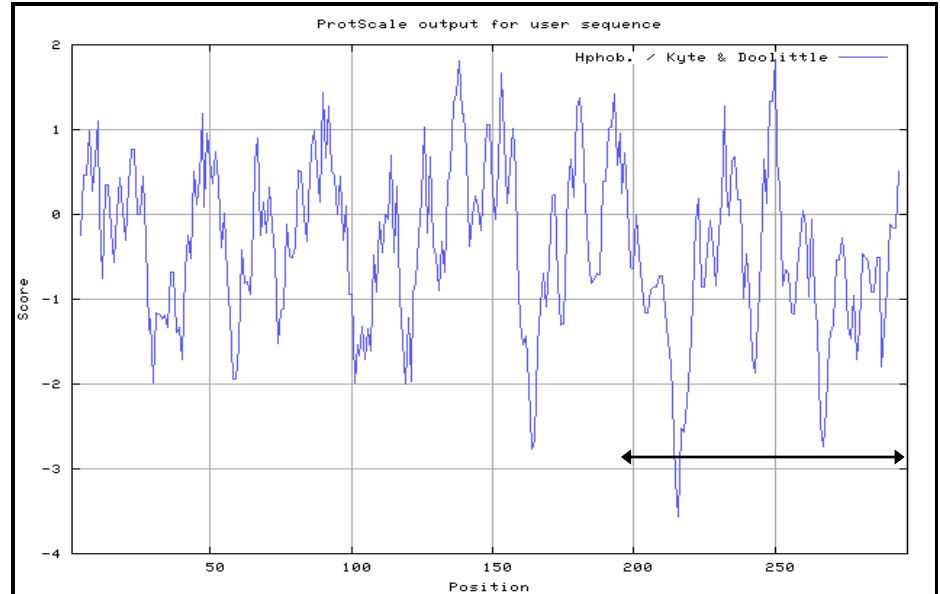
Figure 1. Kyte and Doolittle hydrophobicity profile plot of the VP1 capsid protein of EV71. The more positive the score is, the more hydrophobic the amino acid in that region. The amino acid position of VP1 198–297 was indicated by double-head arrows.